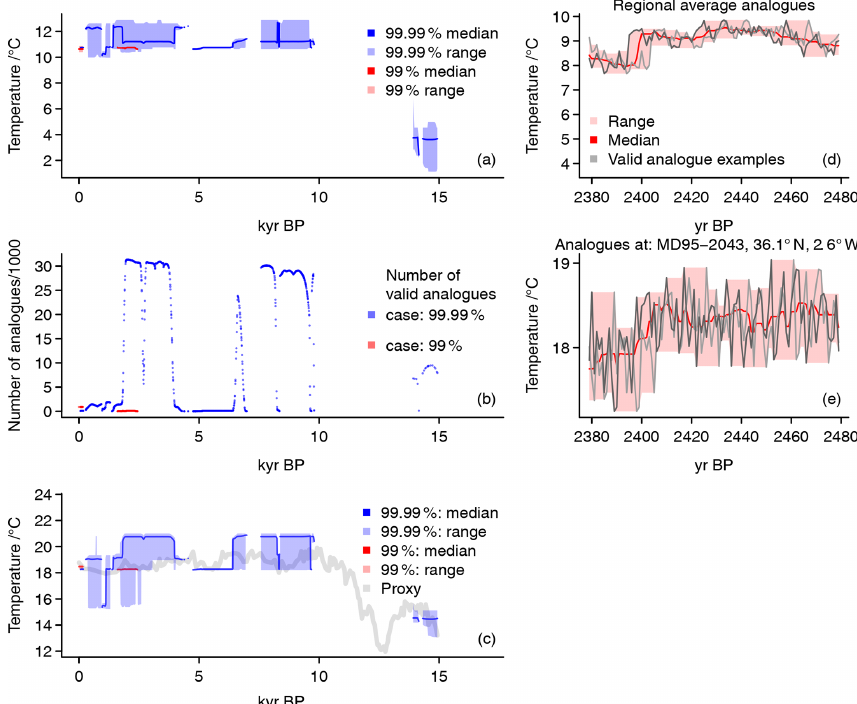
Figure 9. Reconstruction results for the analogue method under two different tolerance assumptions: panel (a) shows median and range of all analogues of regional averages for 101-year moving averages for an assumed 99% tolerance envelope (red) and a 99.99% envelope (blue). Panel (b) provides the number of analogues found for each of the dates considered; red: 99% envelope, blue: 99.99% envelope. Panel (c) adds the proxy data (grey) for the location of the MD95-2043 record, and the range and median of all local analogue values for a 99% envelope (red) and a 99.99% envelope (blue). Panels (d) and (e) give expansions of regional (d) and local (36.1 ◦ N, 2.6 ◦ W; MD95-2043) (e) 101-year moving averages in 101-year series ranges. They give the median (red), the range (light red), and two valid analogue examples of the expansions. Both panels only show results for the 99% tolerance